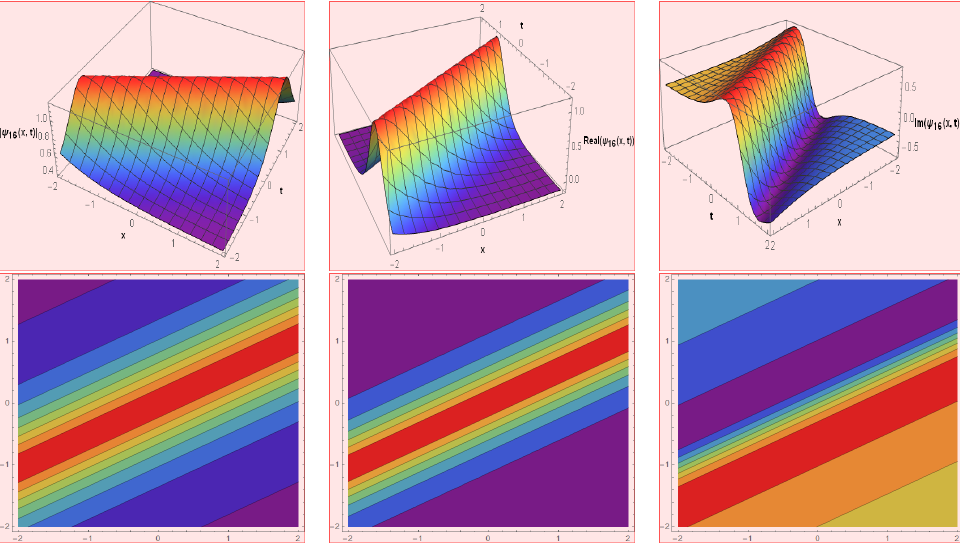
Figure 12. The absolute, real, and imaginary behavior in the shape of 3D and their corresponding contour plots are dispatched for ψ 16 ( x , t )